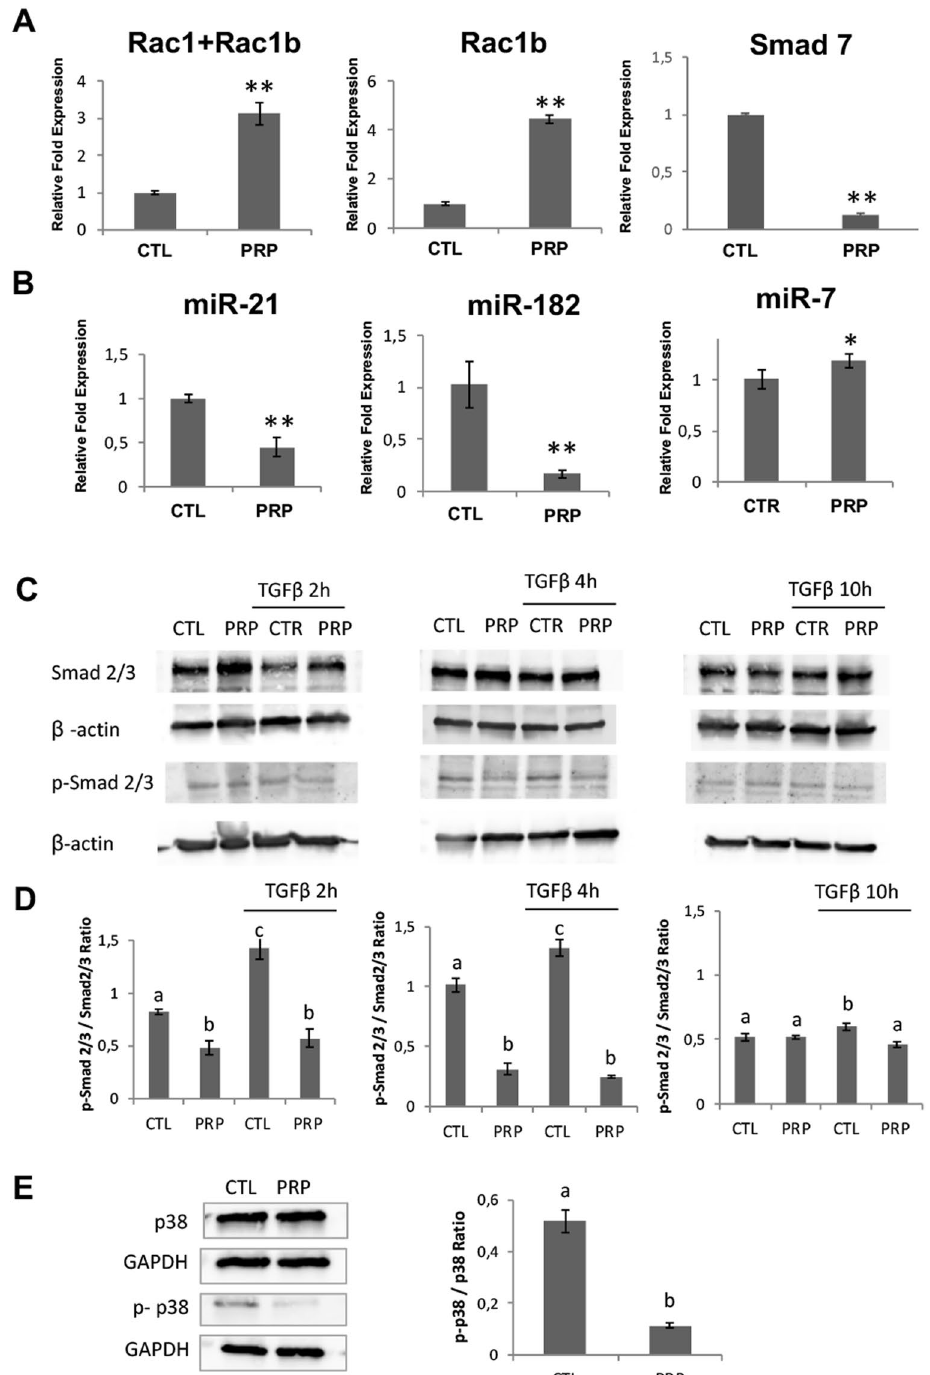
Figure 5. PRP treatment downregulated both Smad-dependent and Smad-independent pathways in TGF β signaling. ( A ) RT-qPCR analysis of Rac1b; Rac1 + Rac1b and Smad 7 after PRP treatment. All gene expressions were normalised to the untreated control. ( B ) RT-qPCR analysis show the fold change of miR-21-5p, miR- 182-3p and miRNA-7. Values were normalized using the UniSp6 RNA Spike-in control primer set. ( C ) Treated and not treated BxPC3 CSCs were incubated with TGF β 1 (5 ng/mL) for 2 h, 4 h and 10 h. The phosphorylation levels of Smad2/3 and total Smad2/3 were analyzed by western blotting at indicated time points. ( D ) The relative expression of p-Smad2/3 and total Smad2/3 normalized to β -Actin was quantified using Image-J software NIH and is shown as a ratio of p-Smad2/3 versus Smad2/3. ( E ) Western blotting analysis of p-p38 and total p38 expression in CSCs treated with PRP versus non-treated. The relative expression of p-p38 and total p38 normalized to GAPDH was quantified using Image-J software NIH and is shown as a ratio p-p38/p38 Different letters stand for significant differences (p <